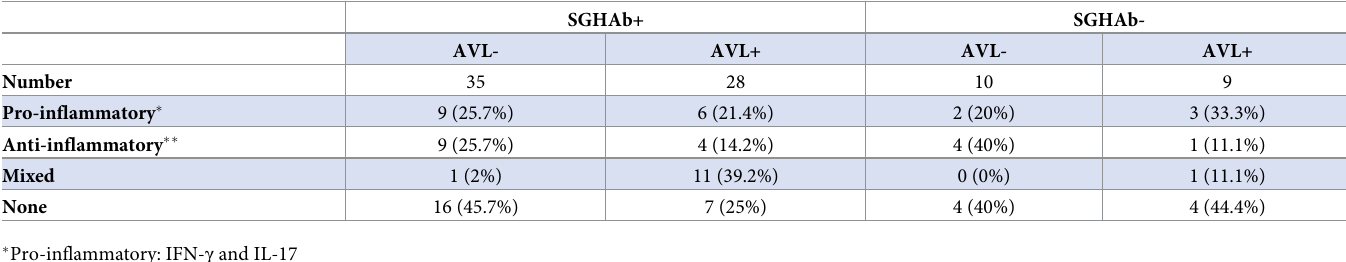
Table 2. Nature of the Cellular Immune Response Based on SGH Antibody Response and Asymptomatic Visceral Leishmaniasis